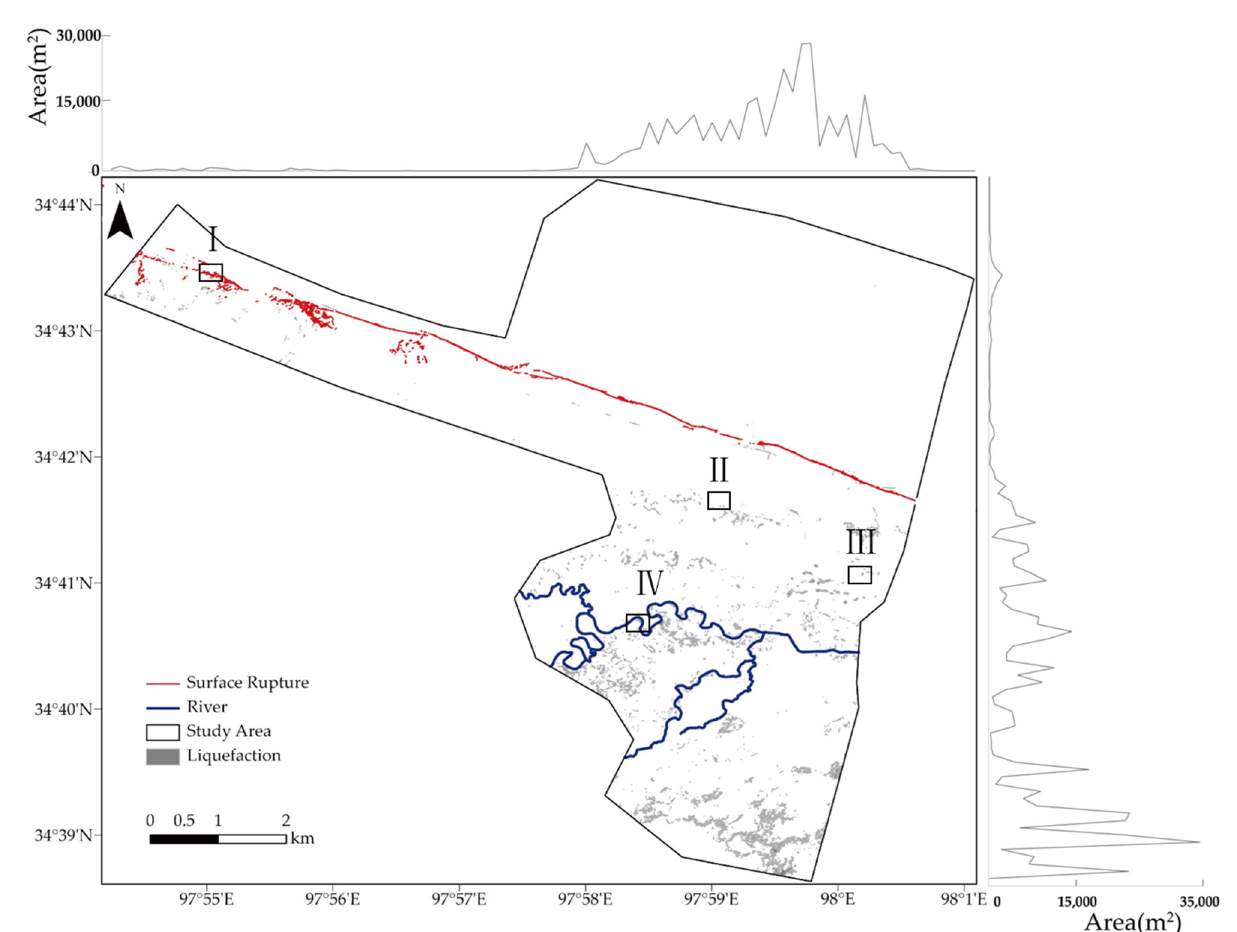
Figure 5. The distribution of liquefaction predicted by RF when the number of training samples was 270; the surface rupture data came from [20].